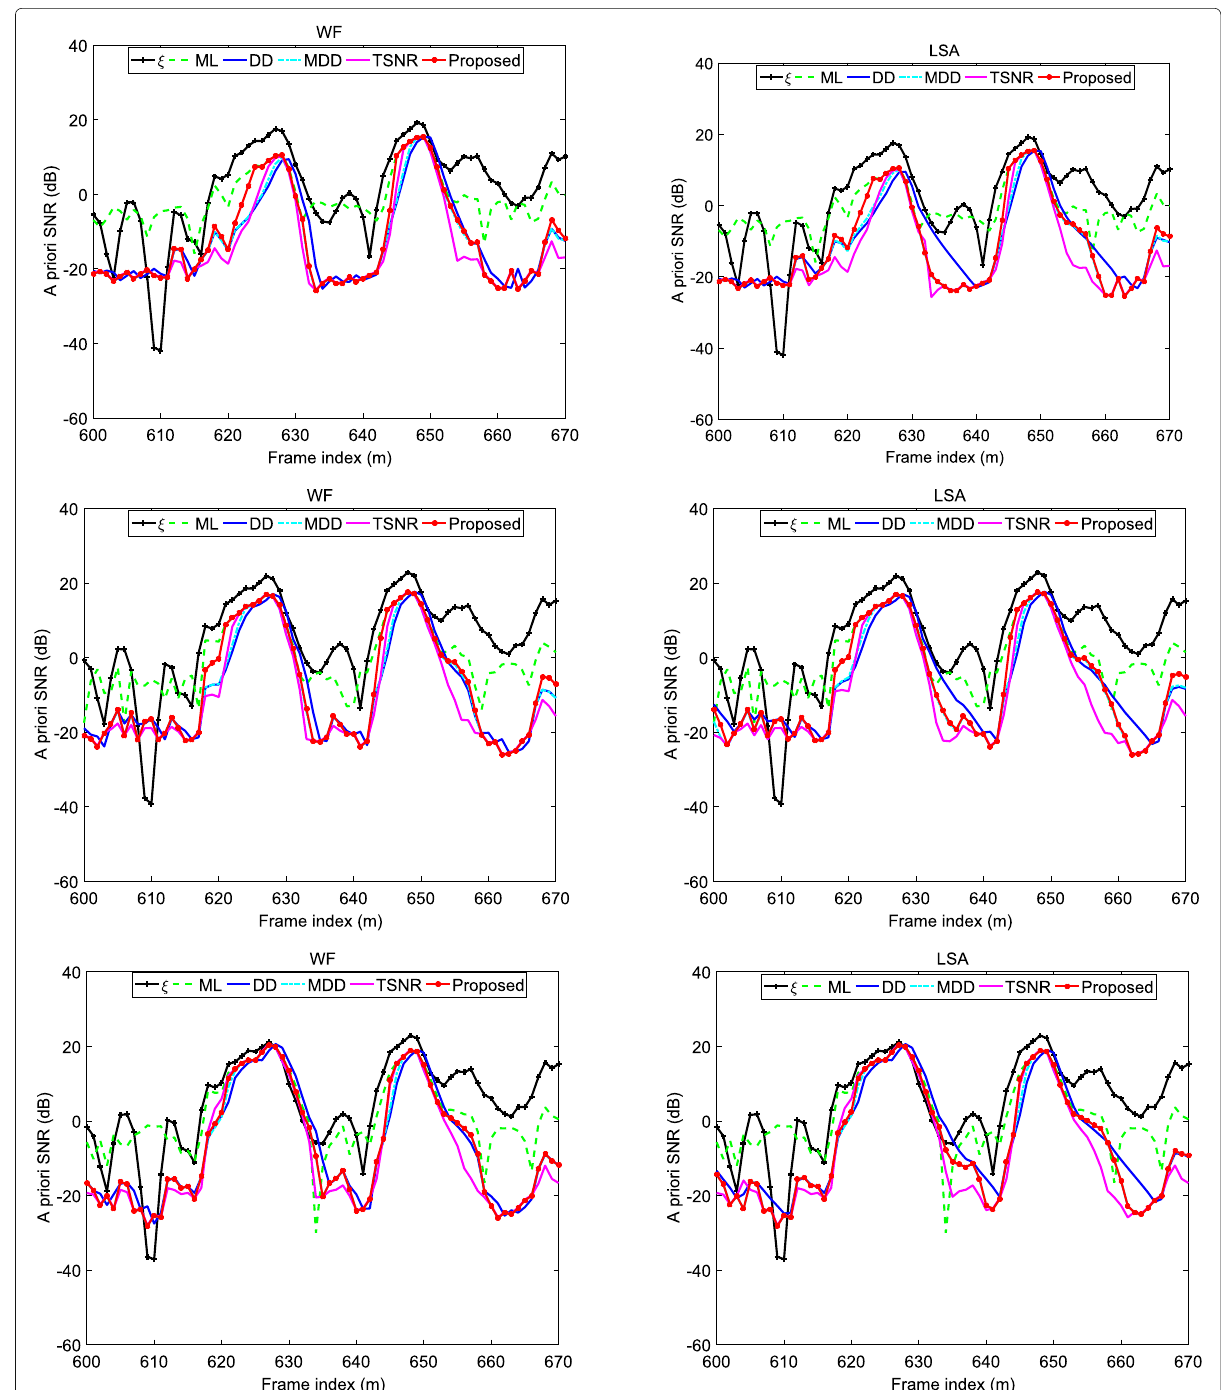
Fig. 4 Comparison of the a priori SNR estimation over a short-time period between the true a priori SNR ξ (black solid line with a marker), ML a priori SNR estimate (green dashed line), ˆ ξ DD (blue solid line), ˆ ξ MDD (cyan dot solid line), ˆ ξ TSNR (magenta solid line) and ˆ ξ prop (red solid line with a marker), at 9th critical band and 10 dB SNR under different background noise: 1st row for pink noise, 2nd row for factory noise, and last row for babble